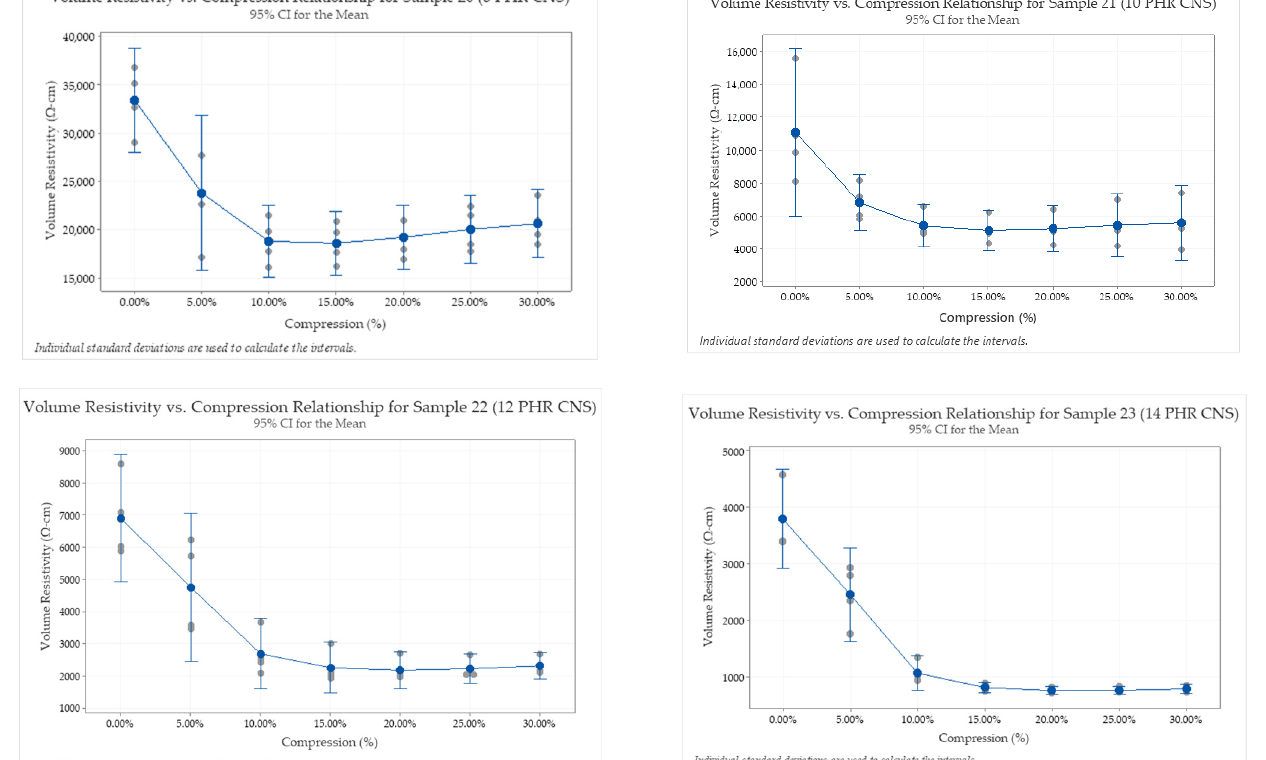
Figure 6. Effect of CNS-filler only, FFKM elastomer O-ring formulations on volume resistivity across multiple compression levels.